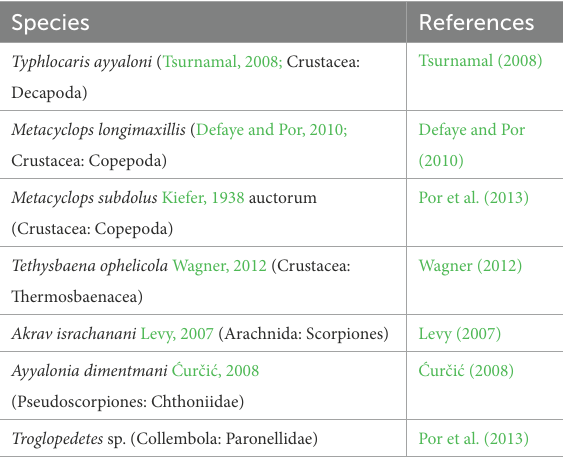
TABLE 2 Arthropod species at Ayyalon